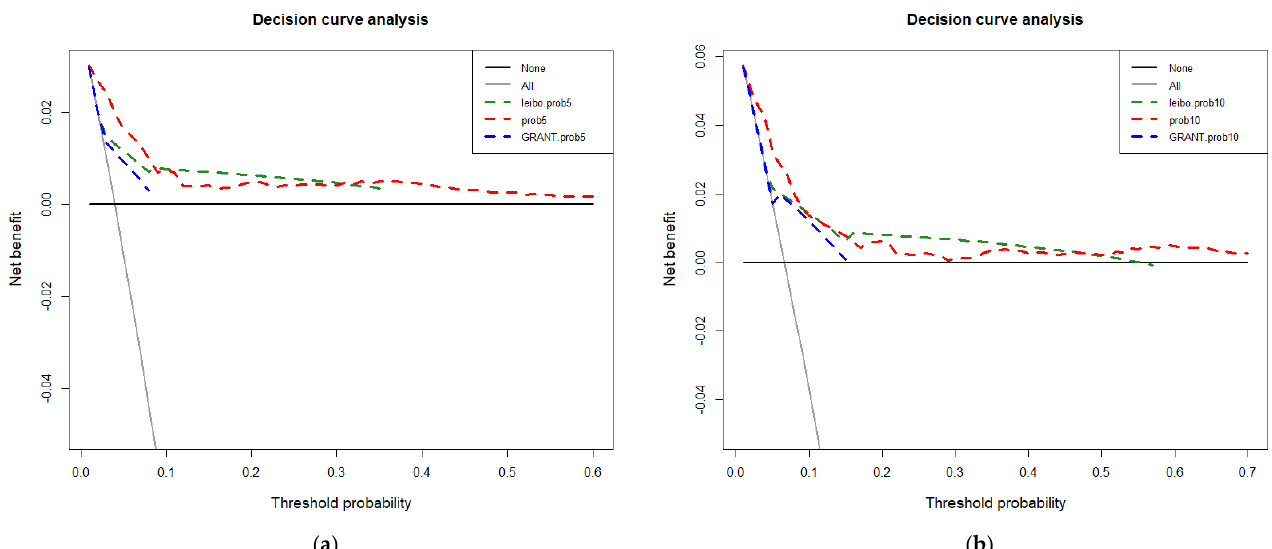
Figure 5. External validation cohort: decision curve analyses quantifying and comparing the perfor- mance of the prognostic models relative to random predictions of cancer - specific mortality: ( a ) 5 - year survival; ( b ) 10 - year survival.